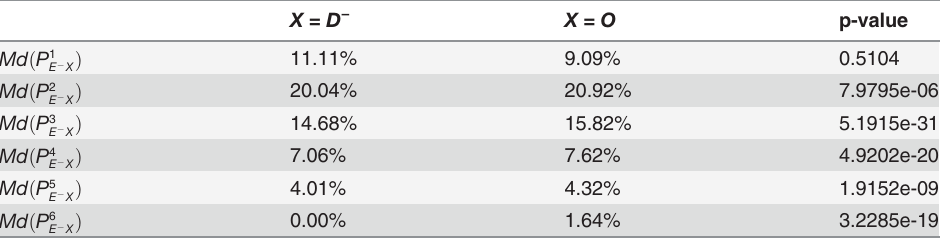
Table 4. Median values of the proportions of non-disease essential proteins among n ( n 2 {1, 2, 3, 4, 5, 6}) neighbors of nonessential disease proteins ( D − ) and other proteins ( O ) in the protein interaction network constructed based on the i2d database.